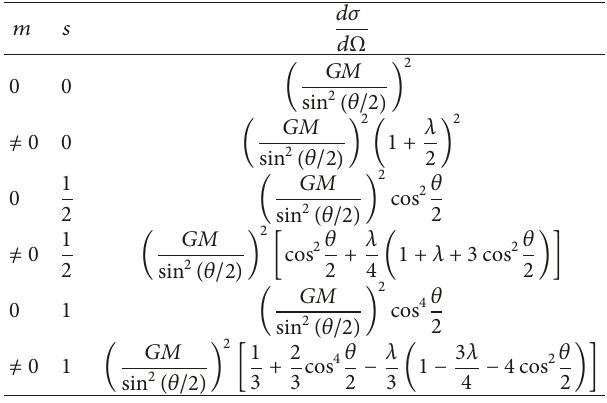
Table 2: Tree-level unpolarized differential cross sections for the scattering of different quantum particles by an external weak Einsteinian gravitational